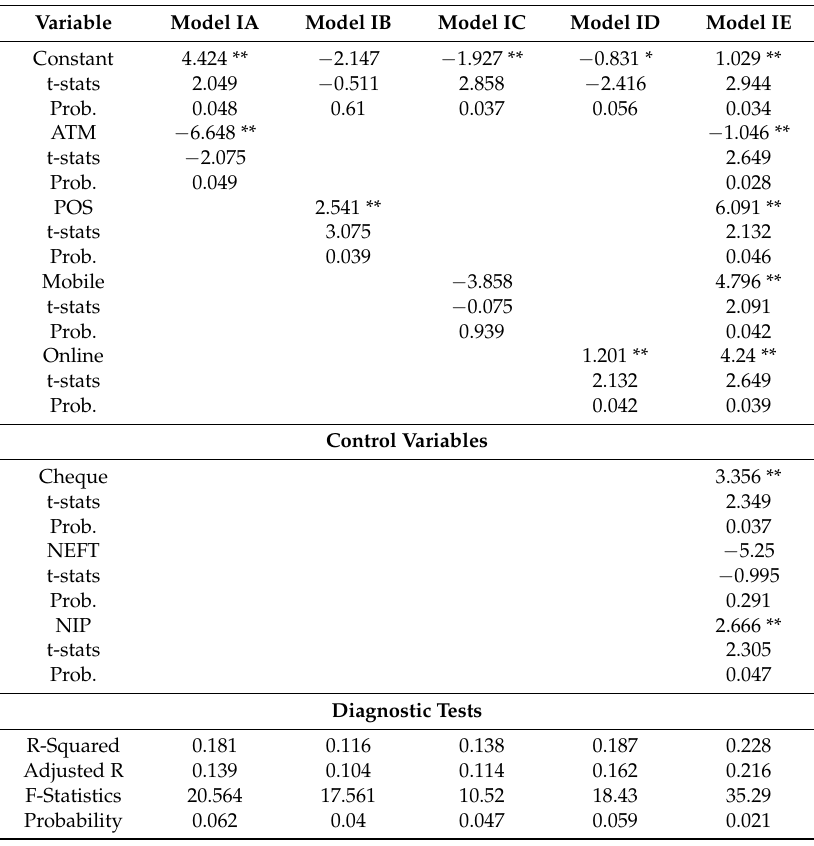
Table 5. Panel Estimates of Model I (Dependent Variable: Performance